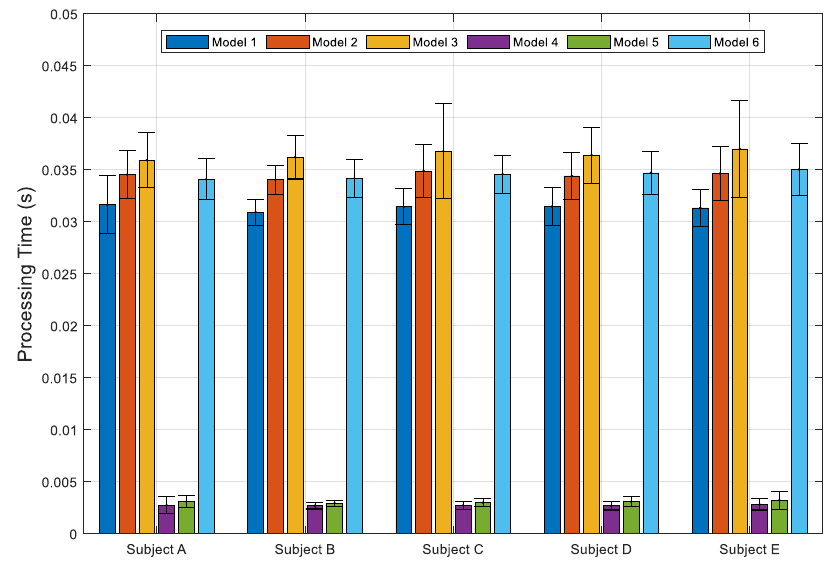
Figure 7. Average processing speed time over five subjects with six models.